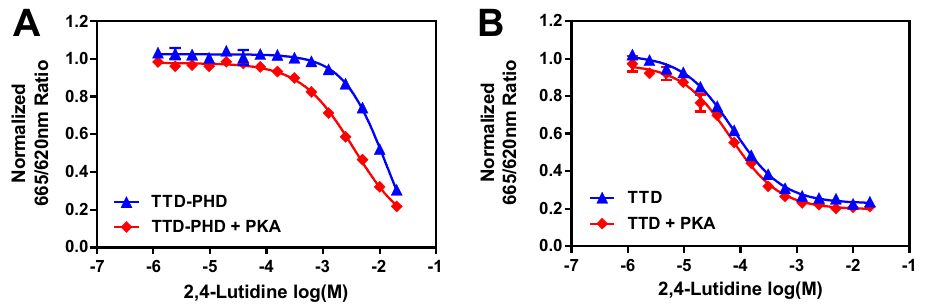
Figure 7. The PKA treatment of TTD-PHD improved 2,4-lutidine inhibition effect. ( A ) Treating TTD-PHD with PKA at 30 °C for 1 h improved 2,4-lutidine inhibition effect on its binding to H3K9me3 peptide in TR-FRET assay. ( B ) Same PKA treatment had no effect on 2,4-lutidine dose-dependent inhibition on TTD- H3K9me3 peptide